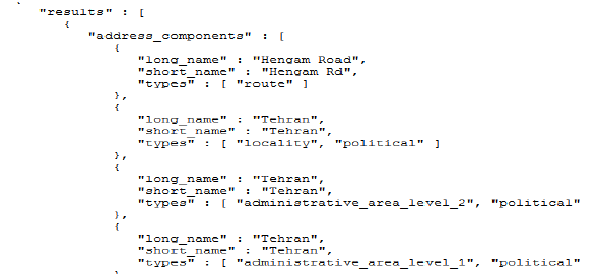
Figure 4 part of the output of Google Geocode web